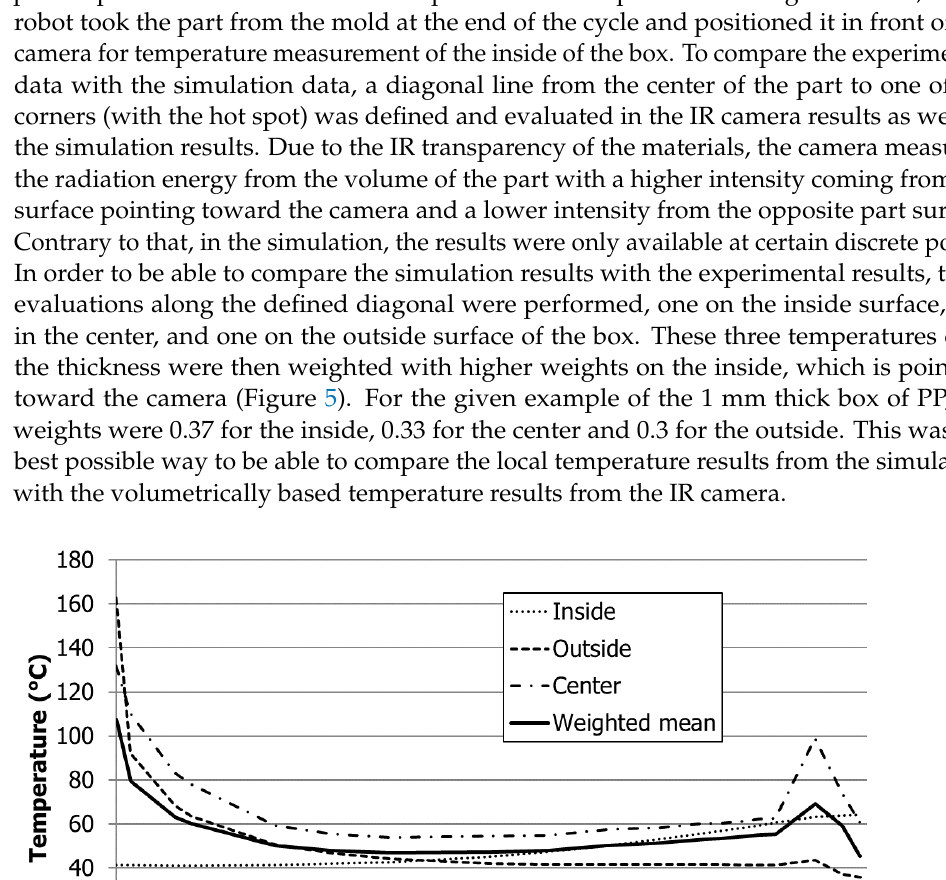
Figure 6. Cycle time reduction of test alloy compared to 1.2343 ESU for different polymers and two wall thicknesses.